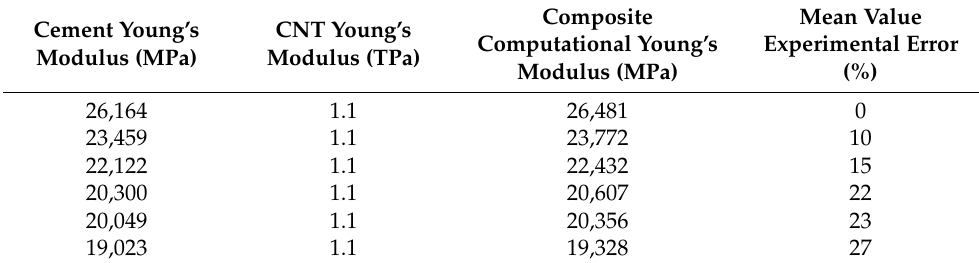
Table 7. Computational results for composite Young’s modulus variation considering different cement Young’s modulus values for a given CNT Young’s